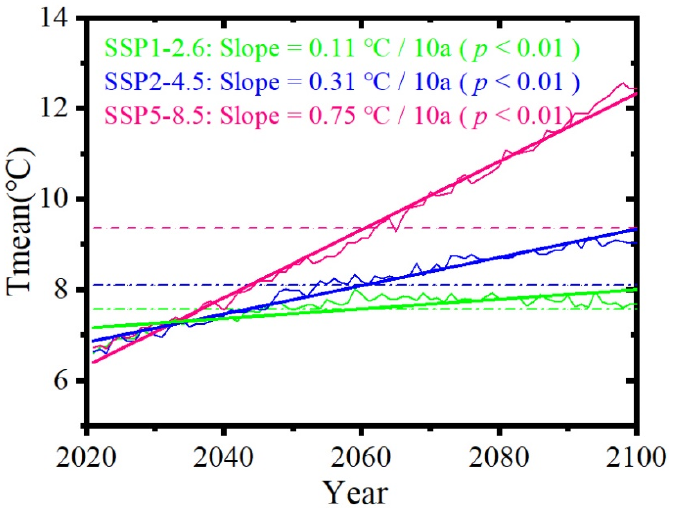
Figure 5. The interannual trends of T mean at the mainland China scale under different SSP scenarios from 2021 to 2100 based on MME. The curves represent time series values, straight lines represent trends, dotted lines represent mean values, and green, blue, and purple represent SSP1-2.6, SSP2-4.5, and SSP5-8.5, respectively.